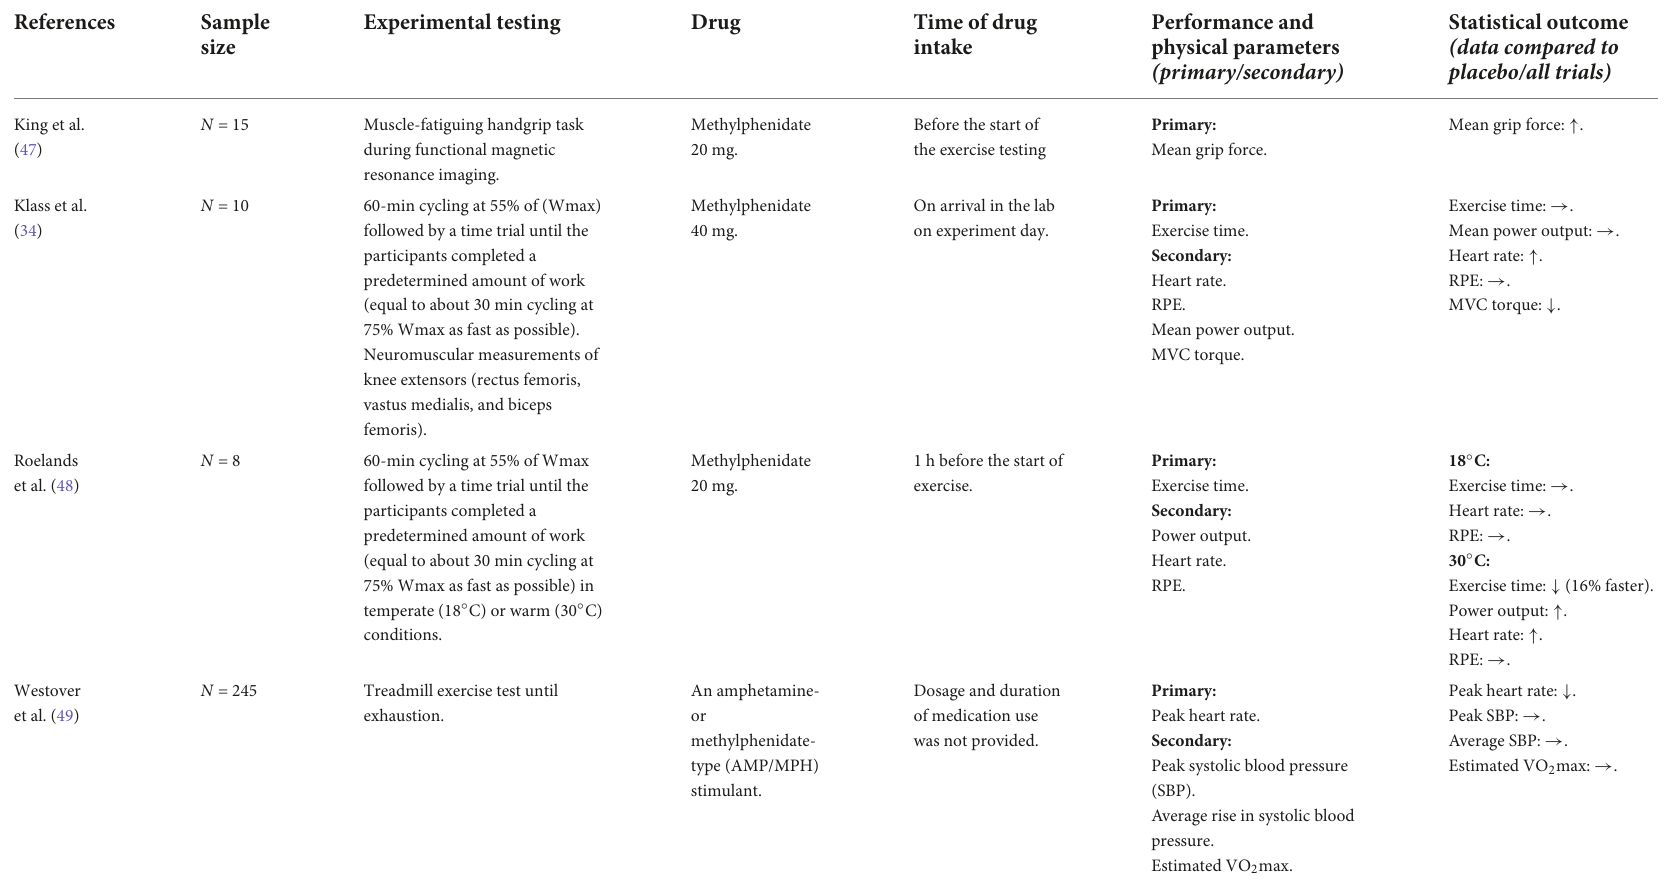
TABLE 5 Stimulants: experimental testing, drug and measured performance parameters.